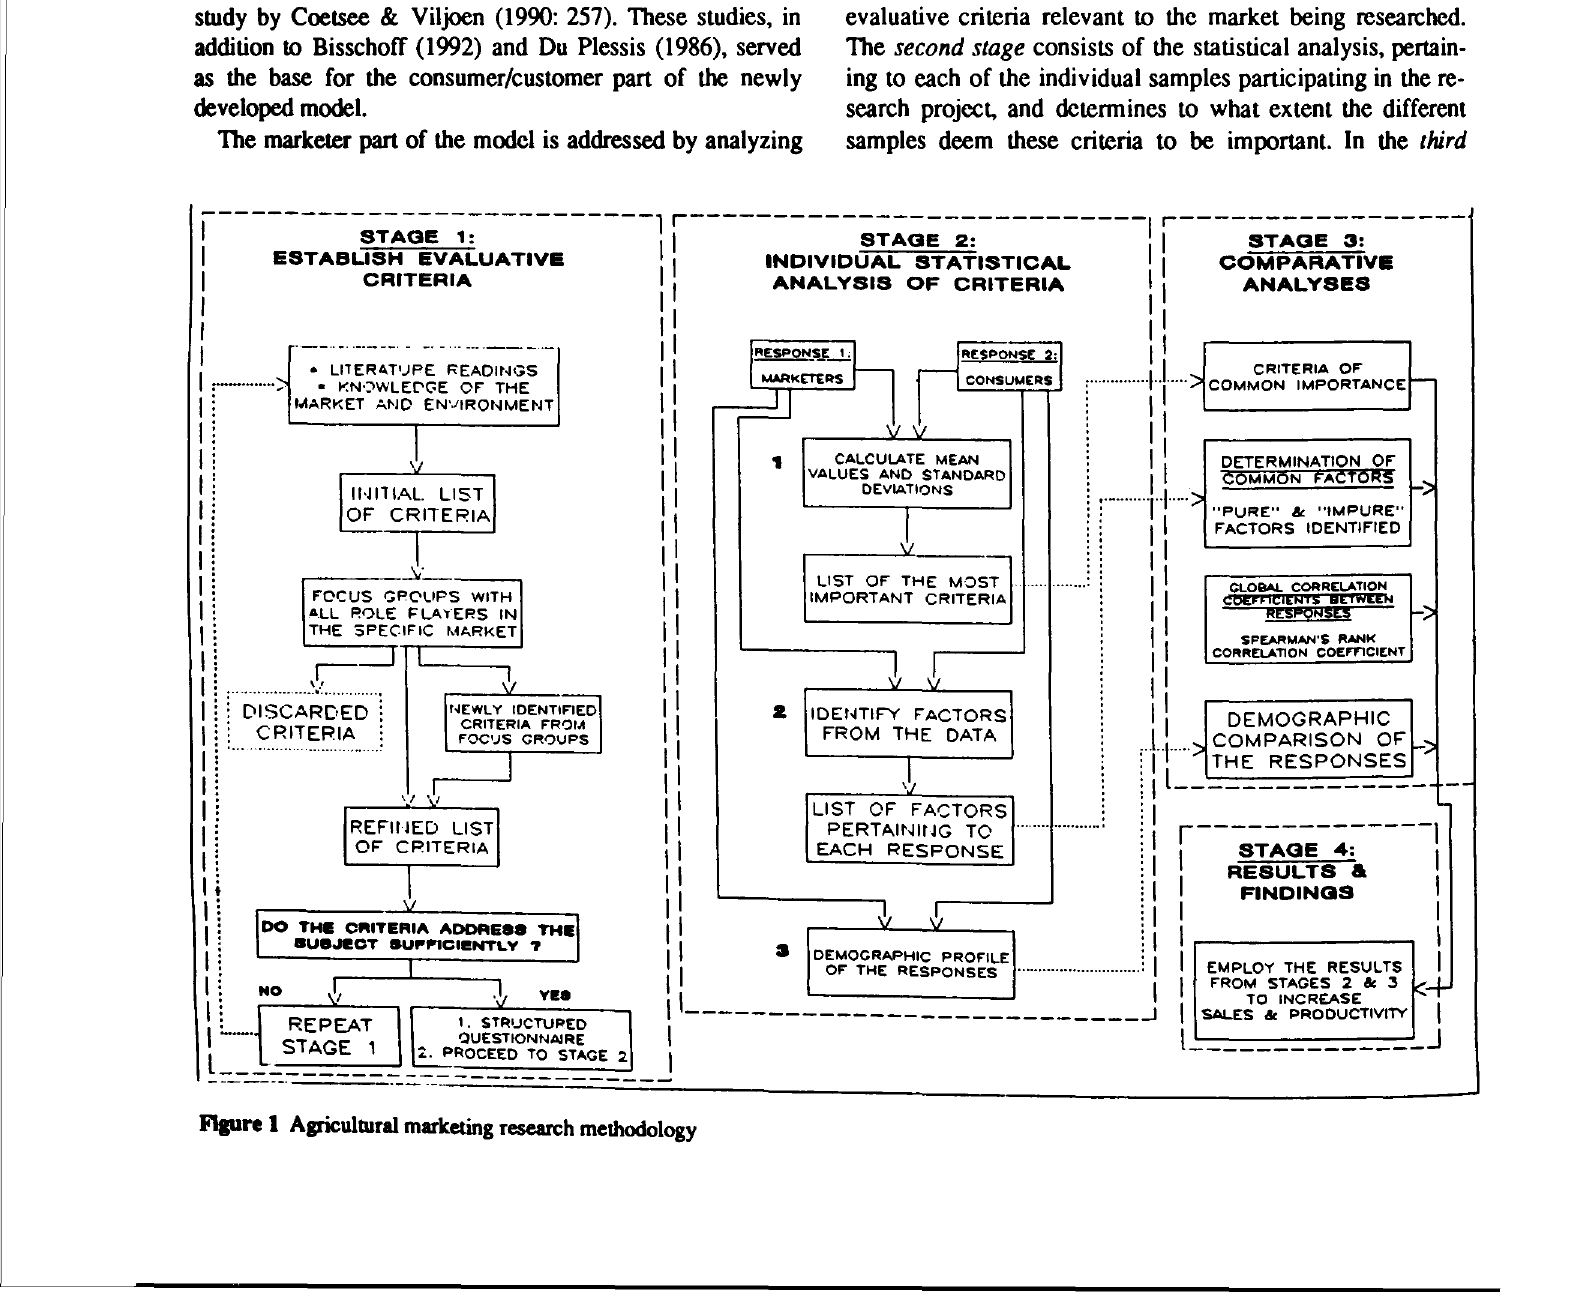
Figure I Agricultural marketing research